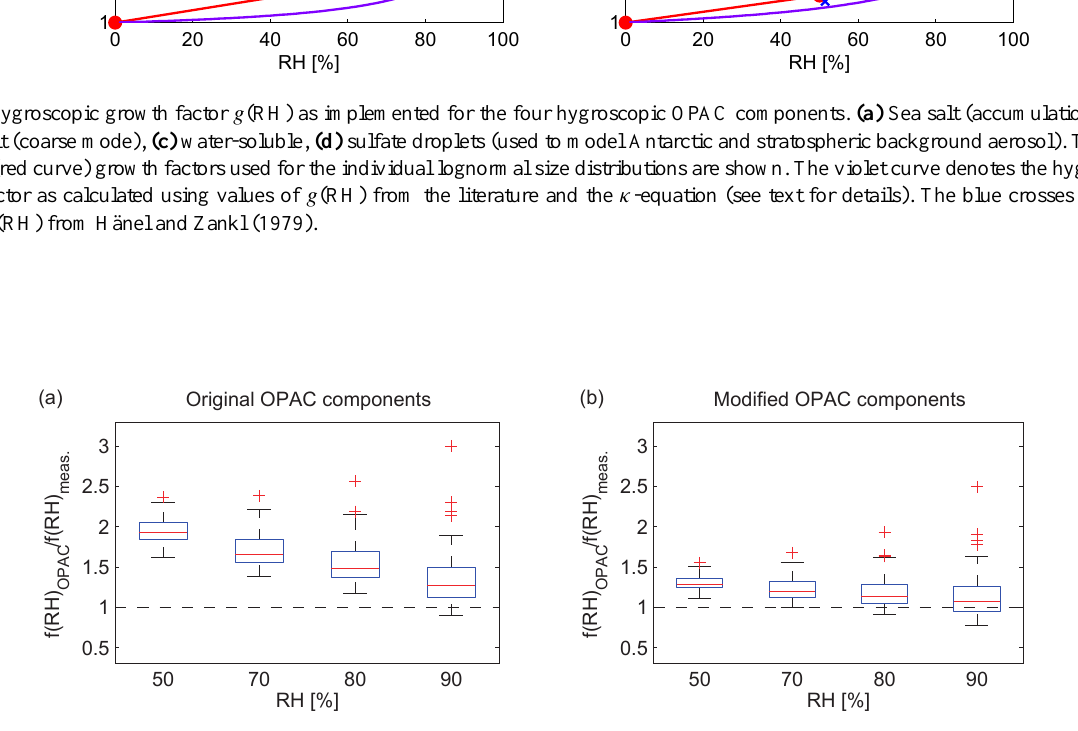
Fig. 12. Box plots of the ratio of calculated to measured f (RH) (at 550nm) for the RH values of 50, 70, 80, and 90% (OPAC values and range of measurements) for Cabauw (4–18 July 2009). The central red mark is the median, the edges of the box are the 25th and 75th percentiles, the error bars show the extent of the most extreme data points that are not considered outliers, while the outliers are plotted individually (red crosses). (a) f (RH) calculated using the original OPAC components weighted with the measured size distribution. (b) f (RH) calculated using the modified OPAC components (changed hygroscopic growth) weighted with the measured size